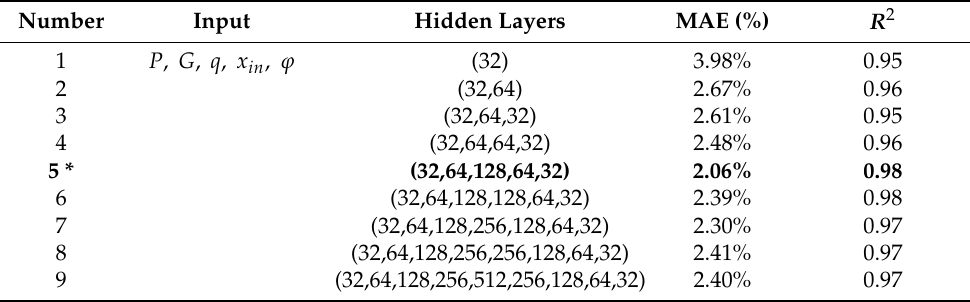
Table 2. The study of hidden layers formation on the predictions.